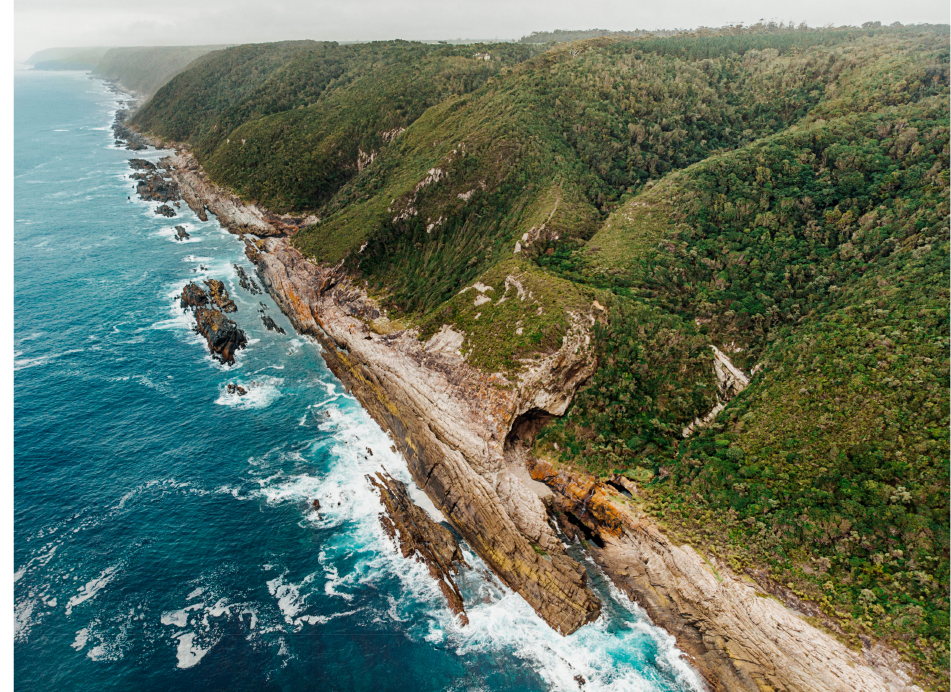
Figure 2. Aerial drone photo of a cave eroded in synclinal folds of the Table Mountain Group quartzites, bordering the Tsitsikamma indigenous forest along the southern coast (Figure 1 for location; see http: // aeon.org.za / remotesensing / for drone video). The flat erosion surface elevated at more than 200 m above sea level is a wave-cut platform that records southern Africa uplift and fluctuated global sea-level drop since about 100